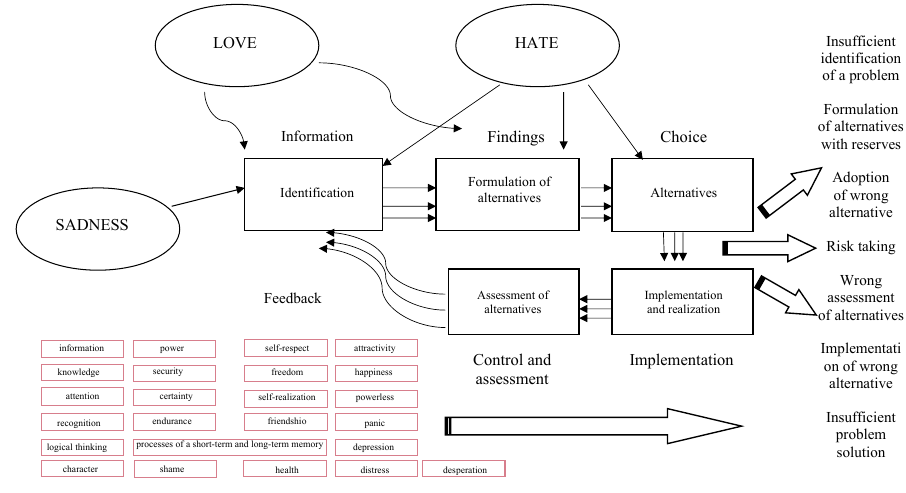
Fig. 2 – The concept of the decision-making process applying three key behavioral factors. Source: own